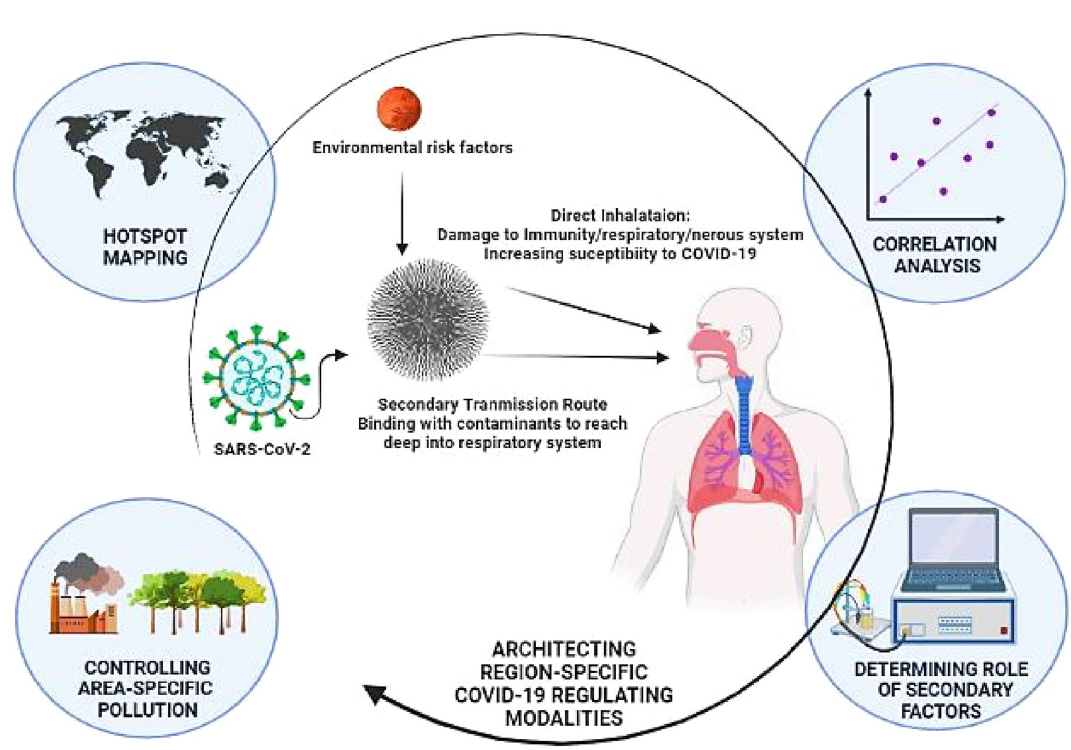
Figure 9. Schematic of outcomes of determining correlation between environmental risk factors and COVID- 19 spread for designing area-specific regulating modalities for effectively combat the pandemic [created with